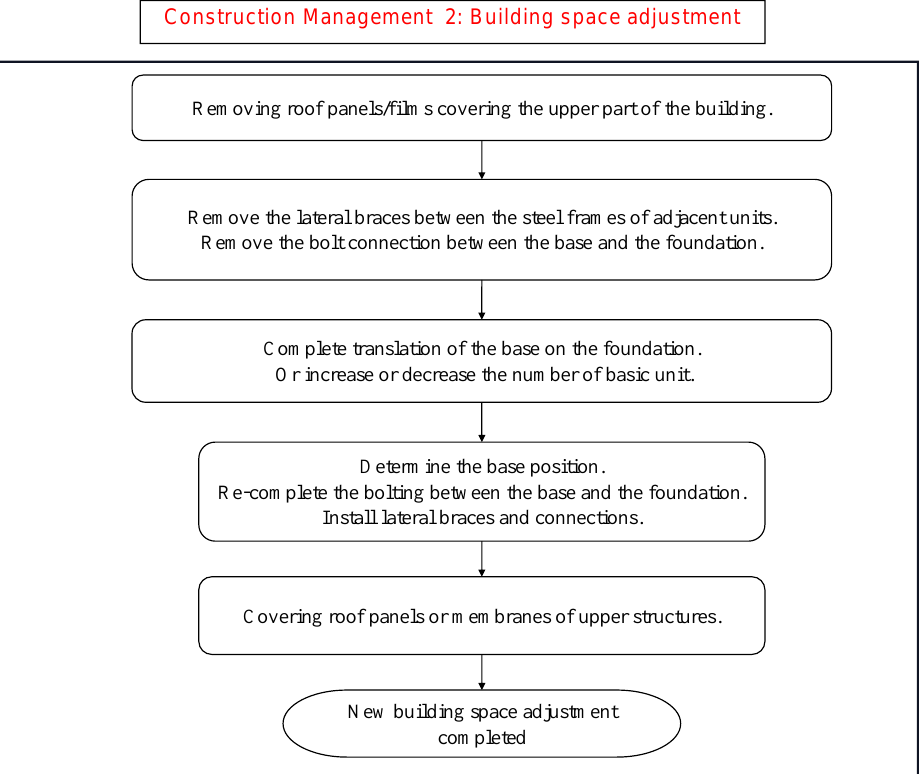
foundation.Removing roof panels/films covering the upper part of the building.